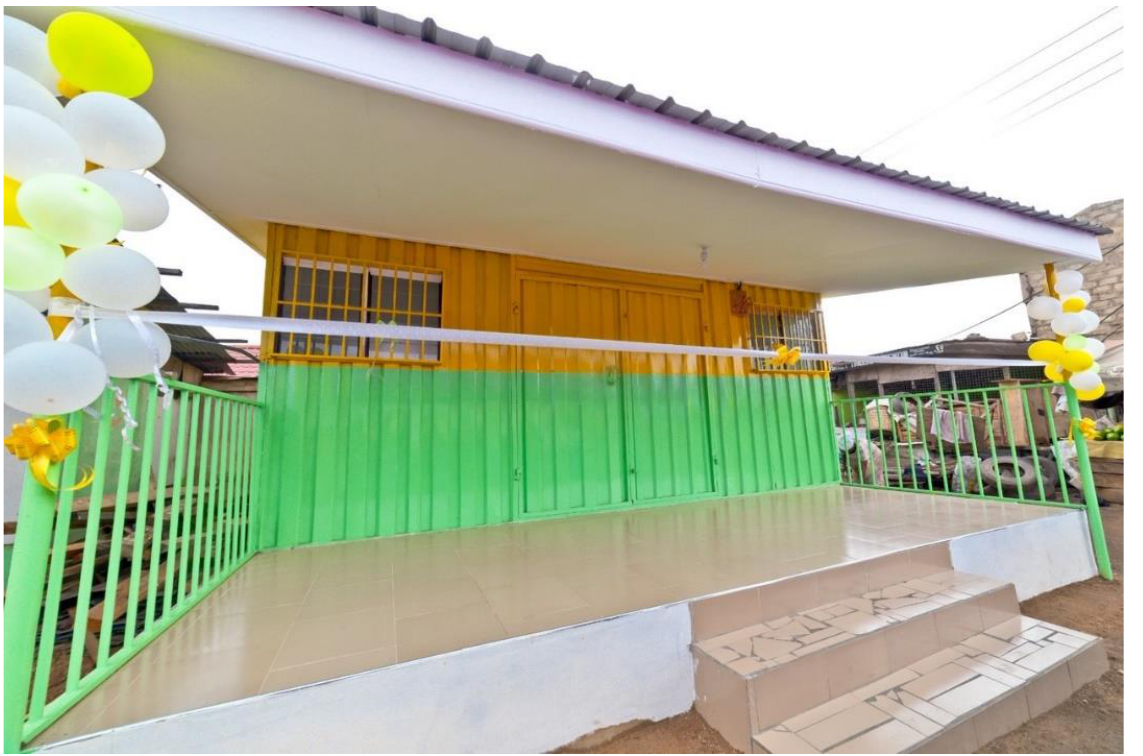
Figure 1. Image of the market container clinic prior to opening in Accra, Ghana, September 2017. The container clinics were built near the previously designated outreach sites. The two sites planned services for an annual catchment child population of 310 children (0–23 months of age) at the fishing community clinic and 422 children at the market